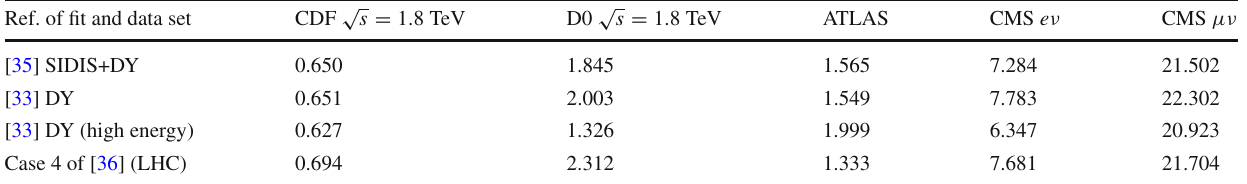
Table 3 χ 2 / N using extractions from different data sets. The PDF is NNPDF31. The first line is the same as in Table 4. For all extractions we have used the NNPDF31 PDF set Ref. of fit and data